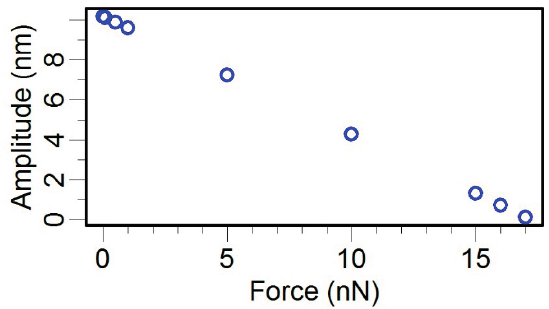
Figure 16. The effect of the transverse viscous force on the oscillation amplitude of the probe